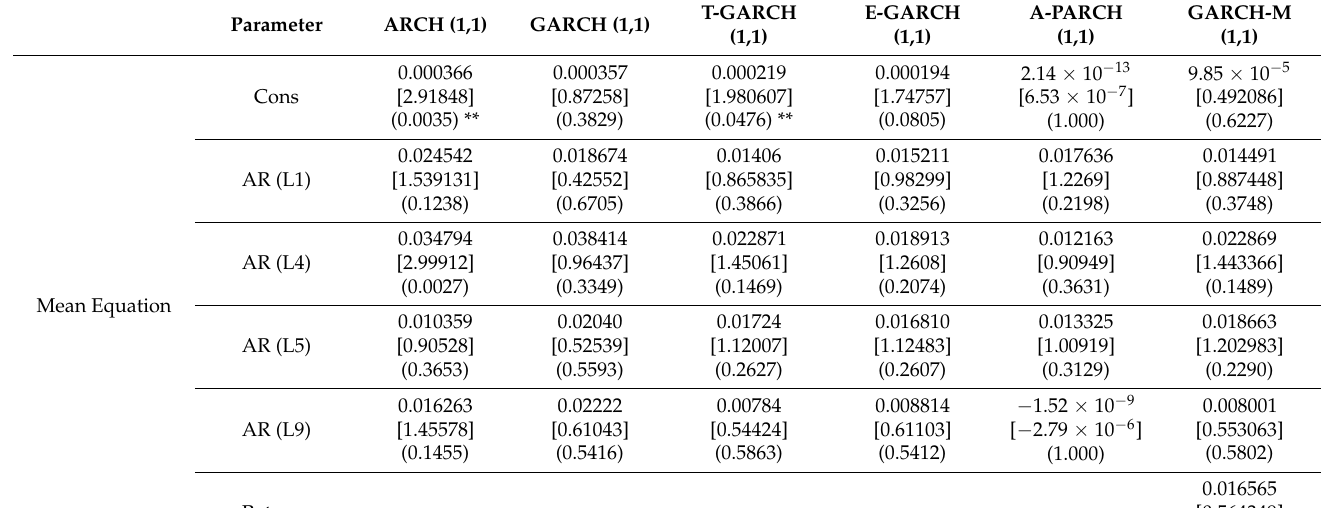
Table 7. Mean and Variance Equation of Gold Price Forecast.